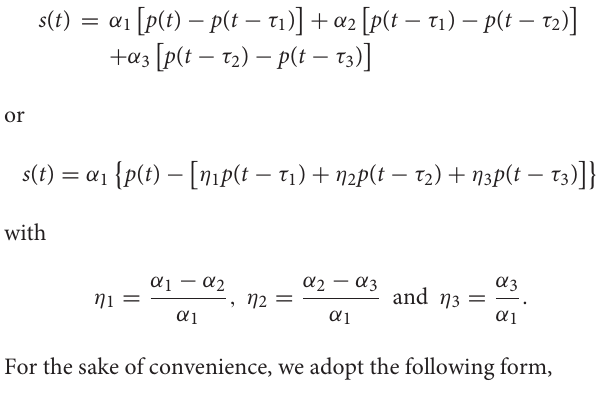
FIGURE 1 | Divisions of the ( α 1 ,α 2 ) plane with α 3 ≥ 0.